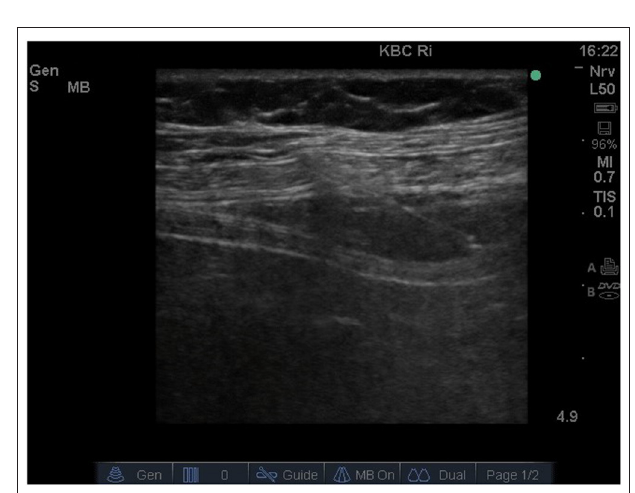
FIGURE 2 | Ultrasound image demonstrating a needle placed in the space between the internal oblique and transversus abdominis muscles (transversus abdominis plane) with the injection of local anesthetic into the target